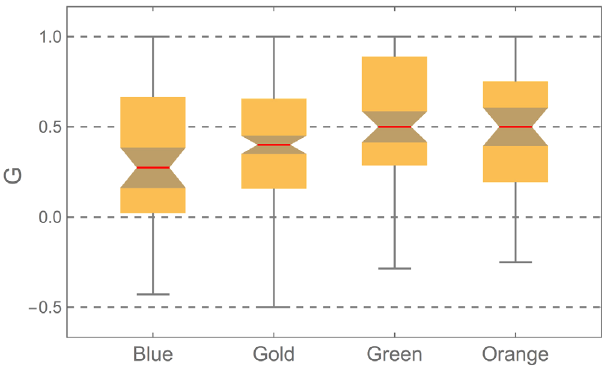
FIG. 7. The normalized gain for different personality types.